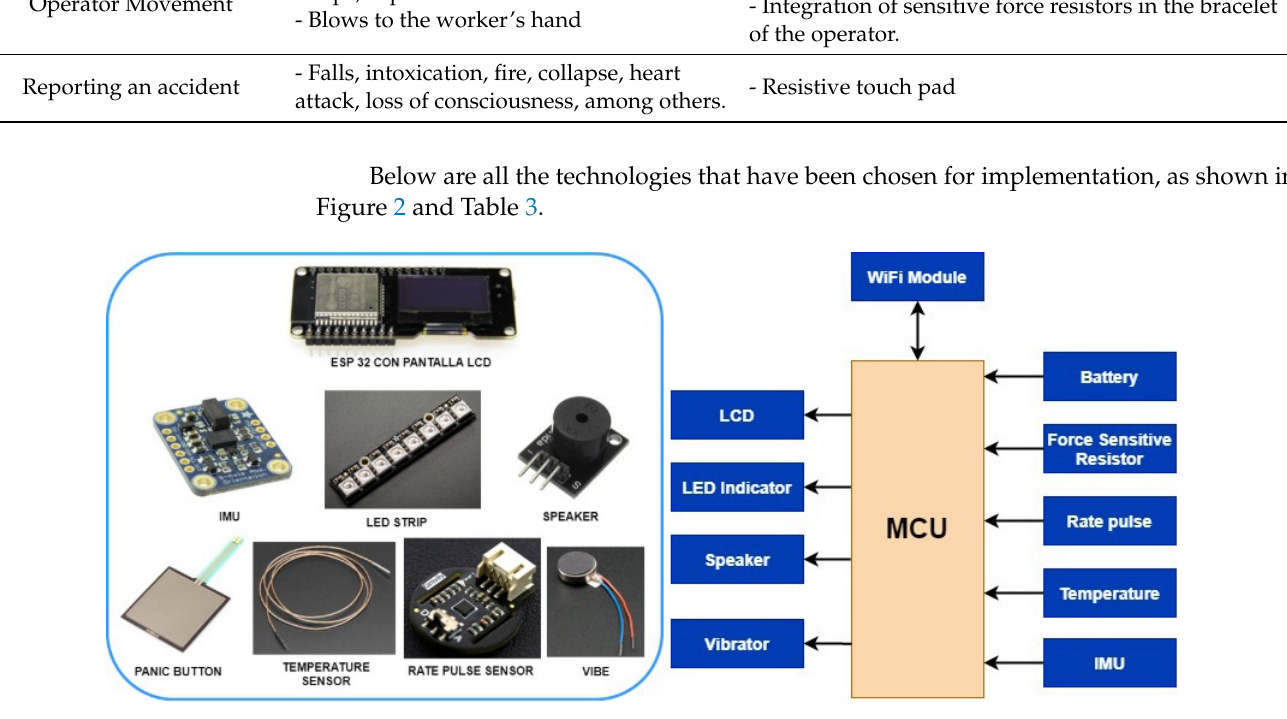
Figure 2. Electronic modules